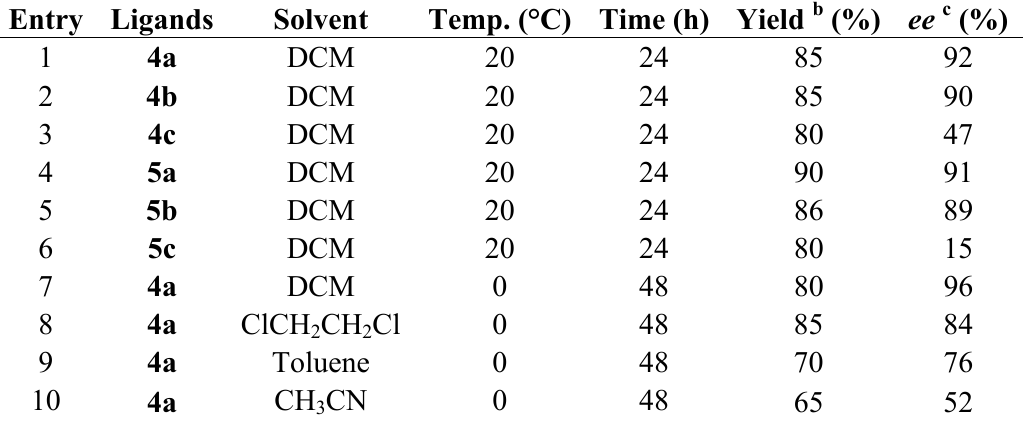
Table 1. Effect of ligands and solvent in the Pd-catalyzed allylic alkylation a .